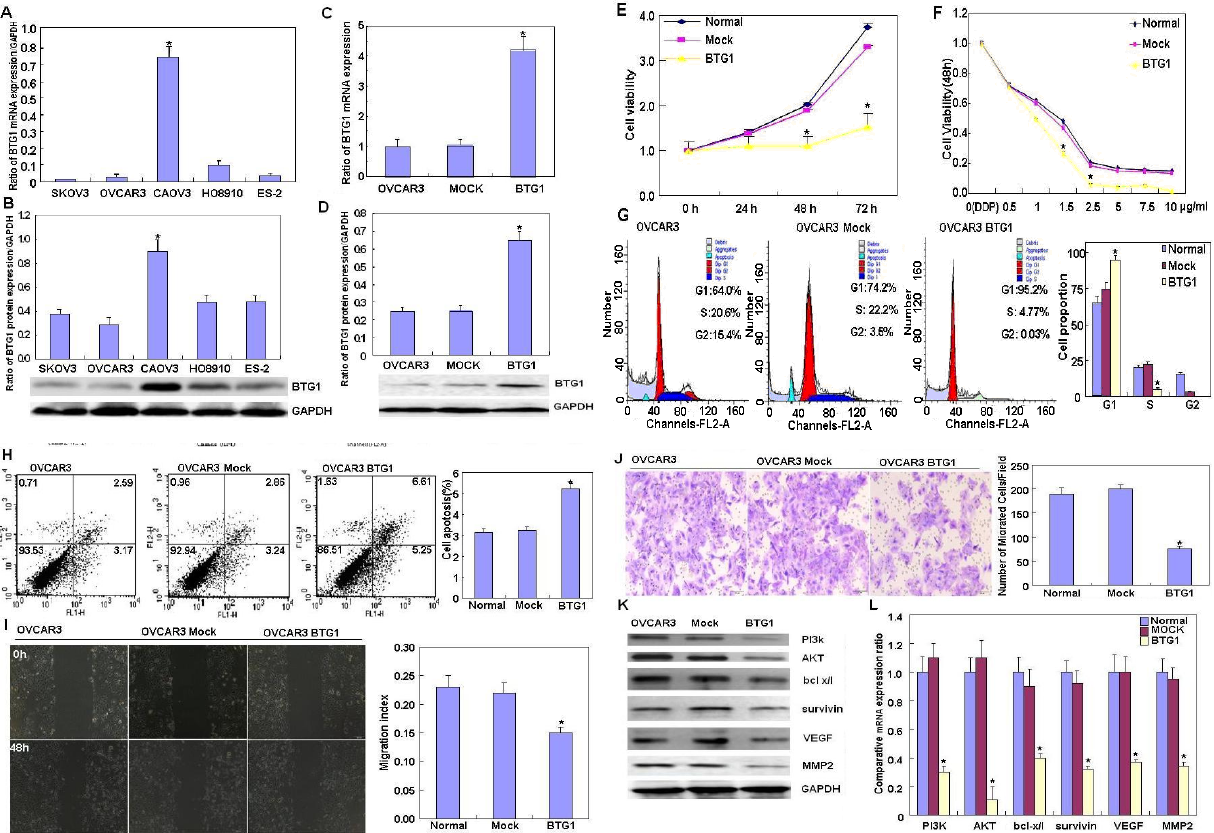
Figure 1. Effects of BTG1 overexpression on the phenotypes and related proteins of ovarian carcinoma cells. BTG1 mRNA and protein expression was screened in ovarian carcinoma cells (OVCAR3, SKOV3, HO8910, ES-2, and CAOV3); BTG1 mRNA ( A ) and protein ( B ) expression in CAOV3 cells was higher as compared with the other cell lines; After transfection with BTG1 -expressing plasmids, BTG1 overexpression was detected in OVCAR3 cells by real-time RT-PCR ( C ) and western blotting ( D ) as compared with control (CTR) cells. The transfectants had lower growth and ( E ) and were sensitive to cisplatin treatment: cell viability decreased significantly at 1.5 μ g/mL and 2.5 μ g/mL cisplatin ( F ); and there was G arrest ( G ); a higher rate of apoptosis ( H ); less migration ( I ); and slower 1 invasion ( J ) as compared to CTR cells. After forced BTG1 overexpression, there was reduced PI3K , Akt , Bcl-xL , survivin , VEGF , and MMP-2 mRNA ( K ) and protein expression ( L ) in OVCAR3 cells. * p < 0.05. Results are representative of three separate experiments; data are expressed as the mean ± standard deviation, with CTR as “1”.